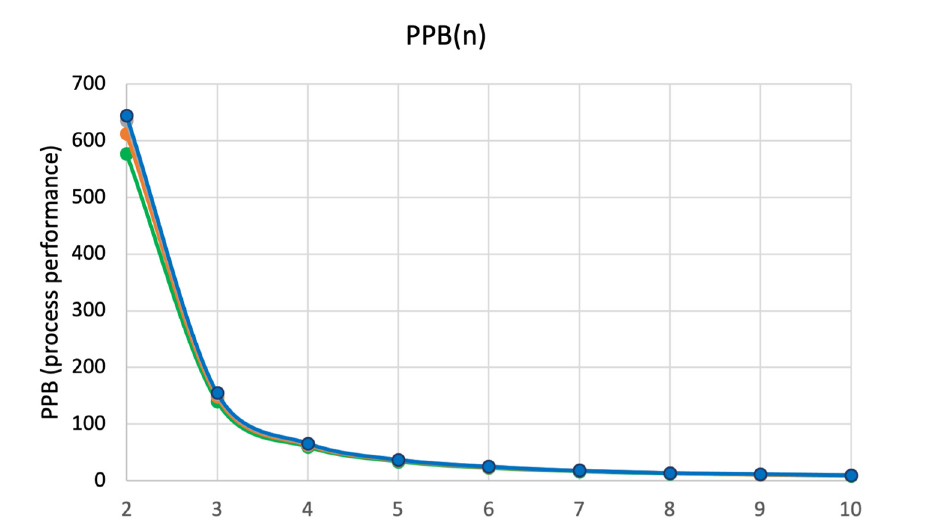
Figure 8. The graphs PPB(n) for n = 2 … 10 and various step sizes.